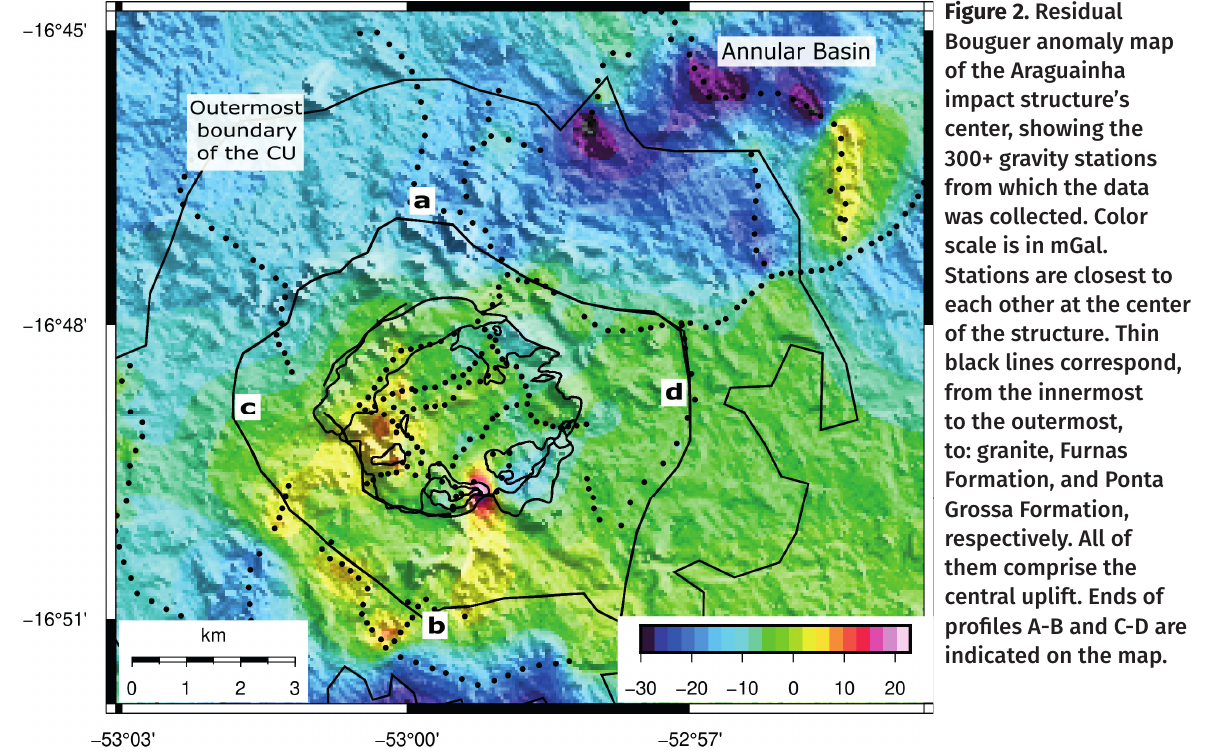
Figure 2. Residual Bouguer anomaly map of the Araguainha impact structure’s center, showing the 300+ gravity stations from which the data was collected. Color scale is in mGal. Stations are closest to each other at the center of the structure. Thin black lines correspond, from the innermost to the outermost, to: granite, Furnas Formation, and Ponta Grossa Formation, respectively. All of them comprise the central uplift. Ends of profi les A-B and C-D are indicated on the